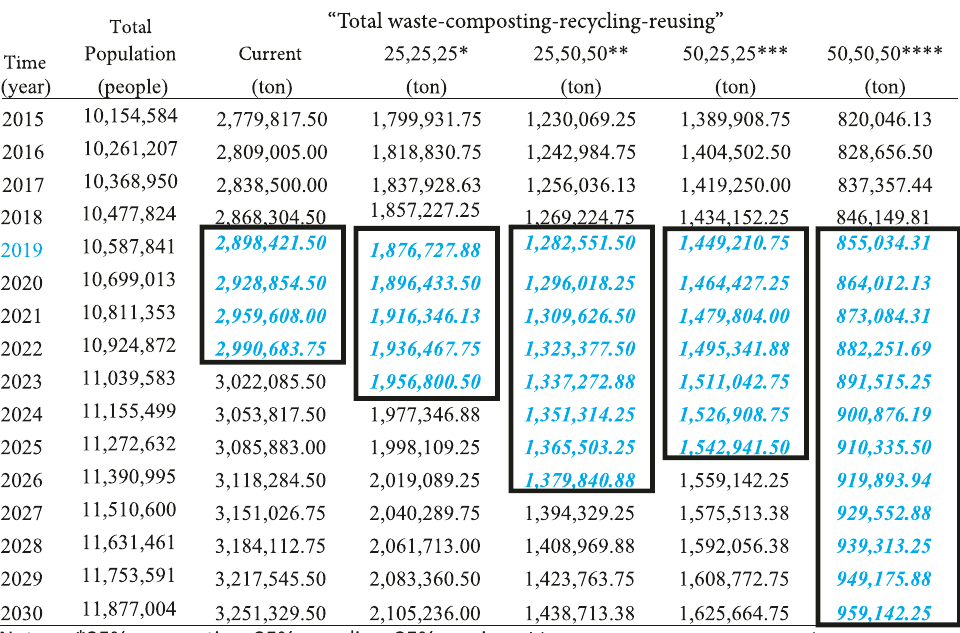
Table 1: Simulation results with various scenarios.